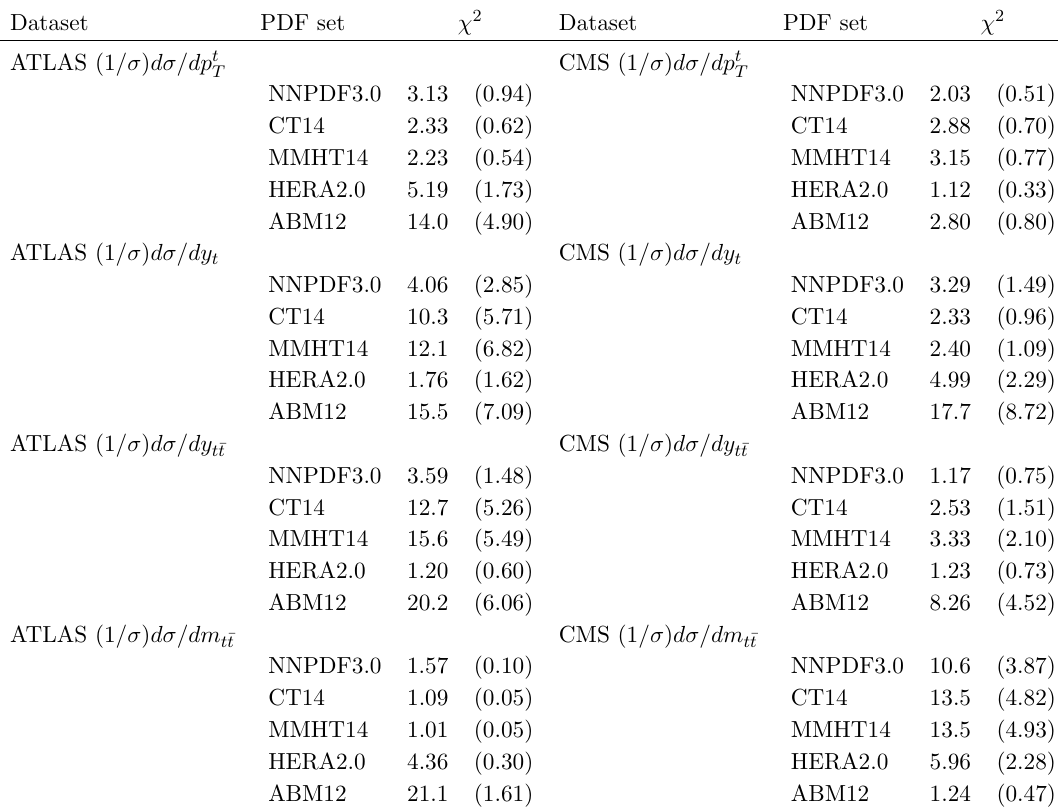
Table 4 . Same as table 3 for the normalized di(cid:11)erential